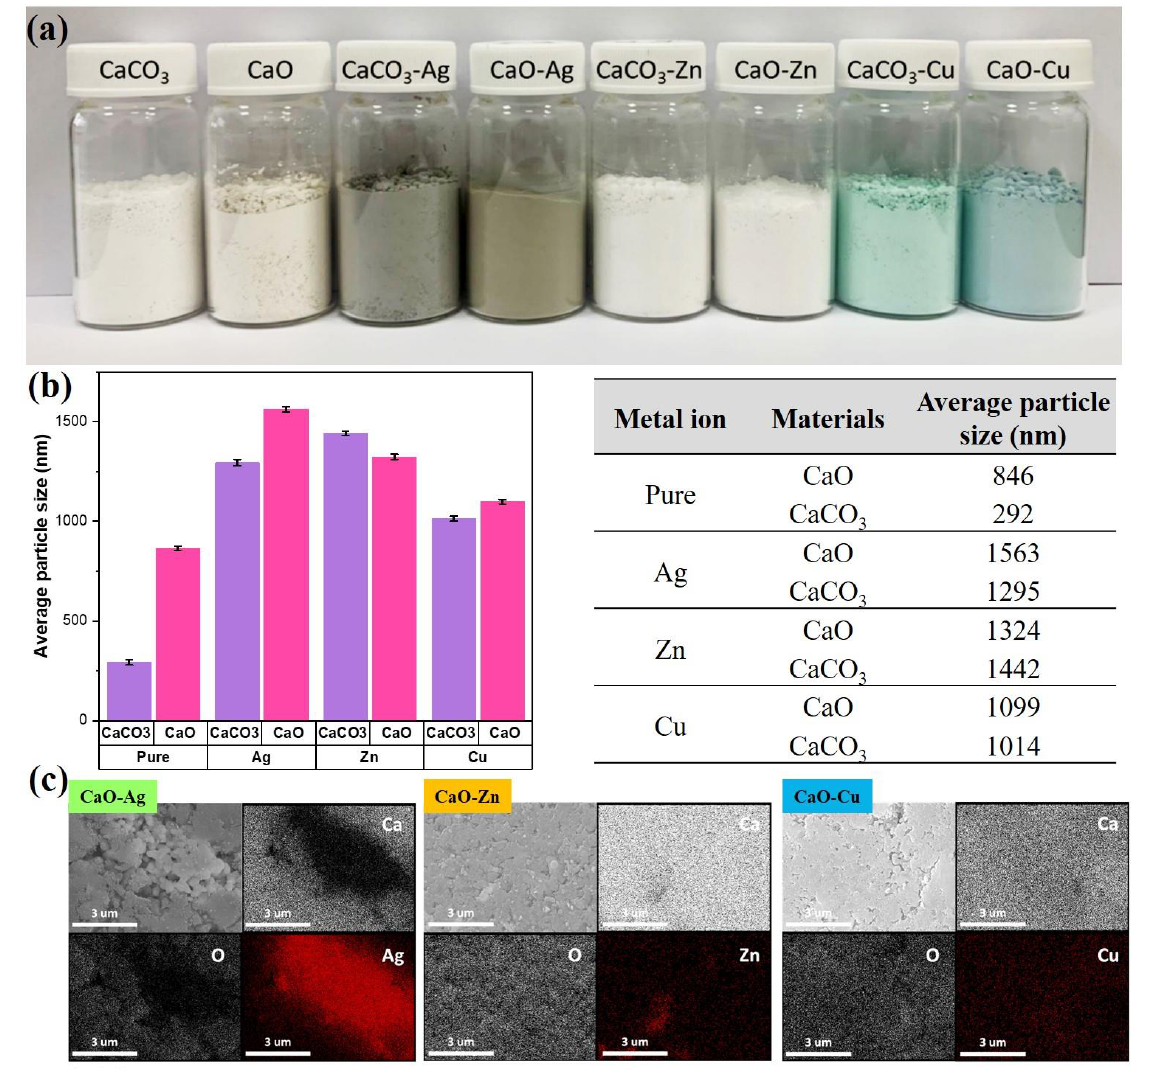
Figure 2. ( a ) Calcium carbonate and calcium oxide from OSP-modified metal ion powder image, ( b ) average particle size analysis of a series of modified metal ion powders of calcium carbonate and calcium oxide. ( c ) EDX spectra of CaO-containing metal ions (Ag, Zn, Cu).